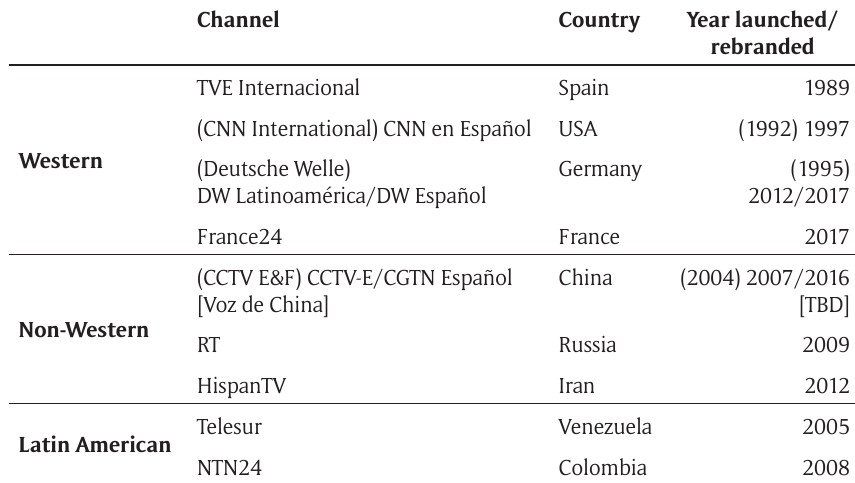
Table 1: International News channels in